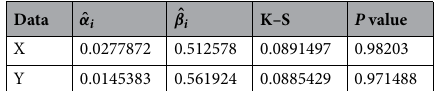
Table 1. MLEs and Kolmogorov–Smirnov test results for data.